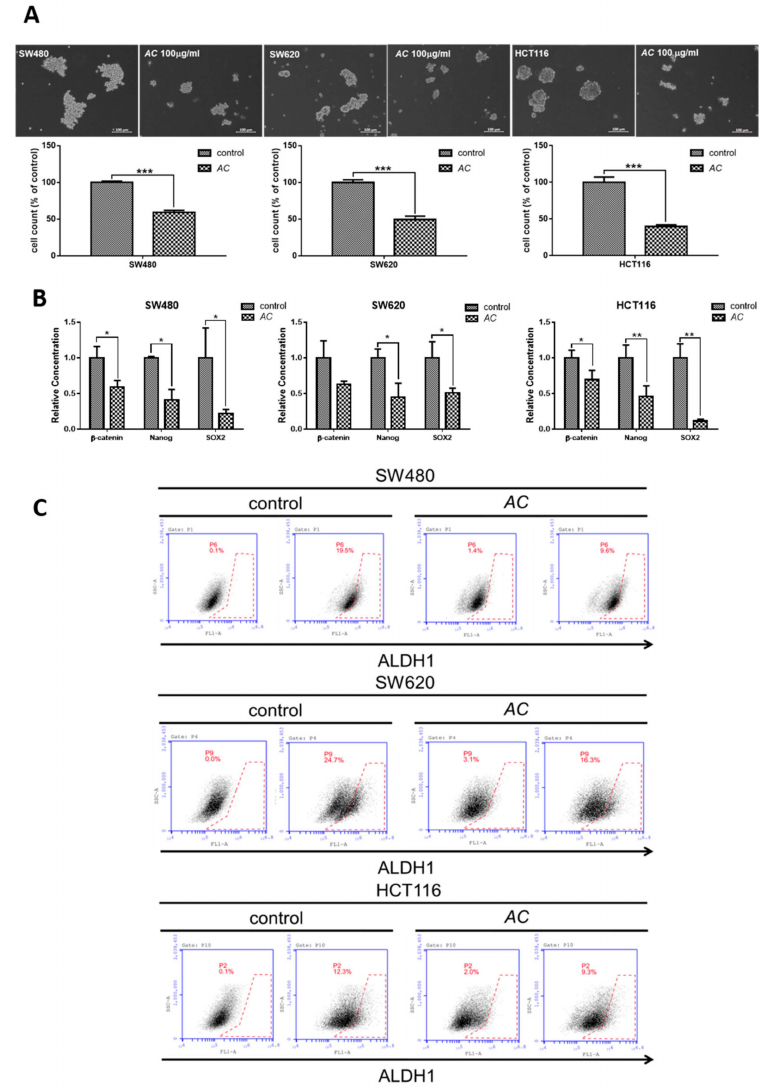
Figure 2. Suppression of cancer stemness by AC treatment. ( A ) Tumor sphere formation assay. Colon cancer cells treated with AC (100 µ g / mL, 48 h) demonstrated a significant reduction in number of tumor spheres generated under serum-deprived culture conditions. *** p < 0.001. ( B ) q-PCR analysis showed that AC treatment down-regulated cancer stem cell markers β -catenin, SOX-2, Nanog. ** p < 0.01, * p < 0.05. ( C ) Aldefluor assay showed that AC treatment (100 µ g / mL, 48 h) prominently and dose-dependently reduces the ALDH1 enzymatic activity in all three colon cancer cell lines